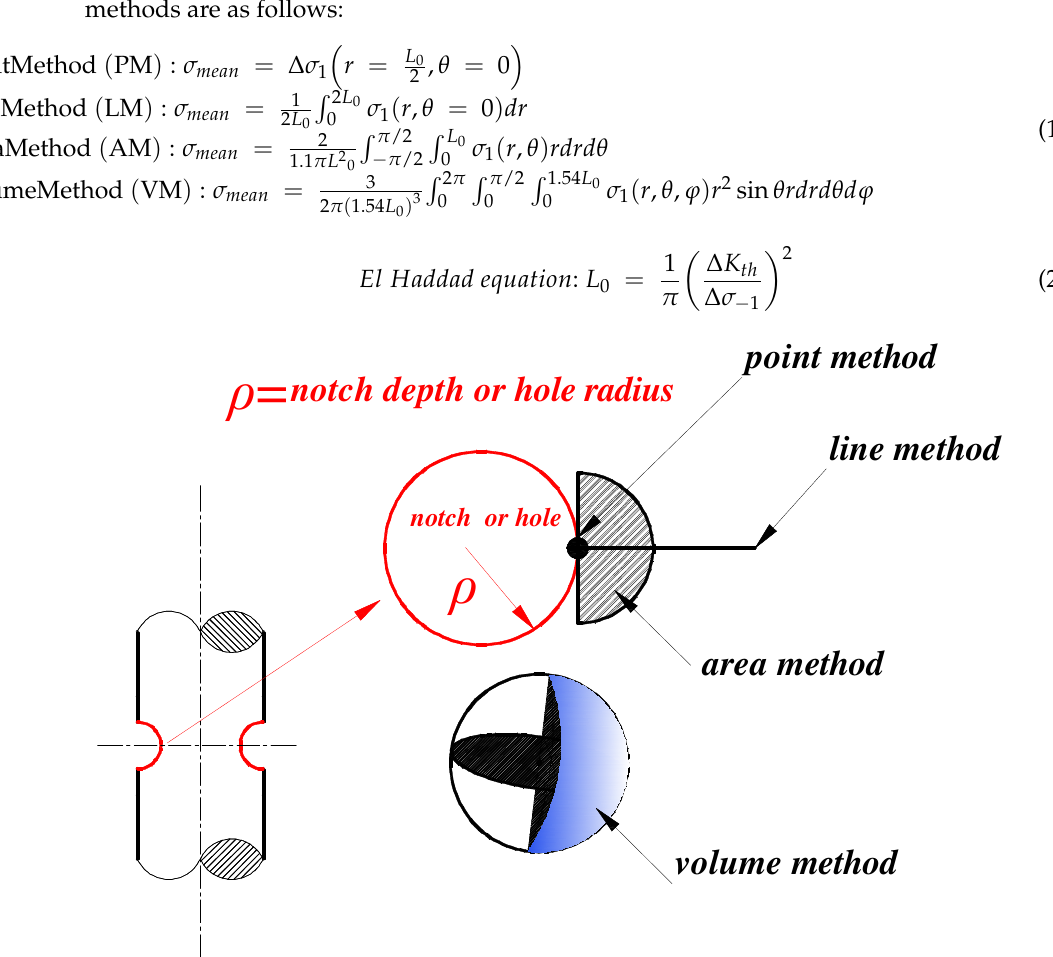
Figure 1. Visualization of the point method, the line method, the area method, and the volume method.